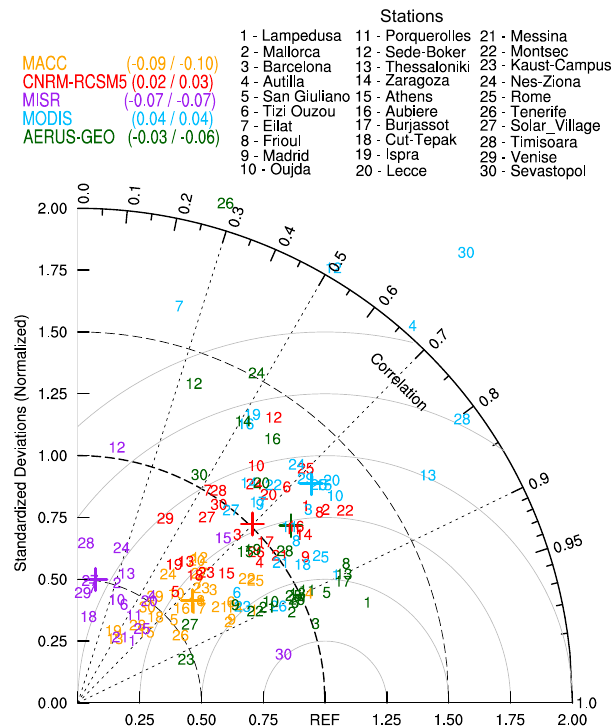
Figure 4. Taylor diagram evaluating CNRM-RCSM5 (red), MACC (orange) and satellite (MODIS, blue and AERUS-GEO, green) data against 30 AERONET ground-based observations in terms of daily AOD in summer 2012. Averages over the 30 stations for each dataset are indicated with crosses. The mean bias against AERONET is indicated in the caption between brackets (all the 30 stations / the 9 stations located to the north of 33 ◦ N).